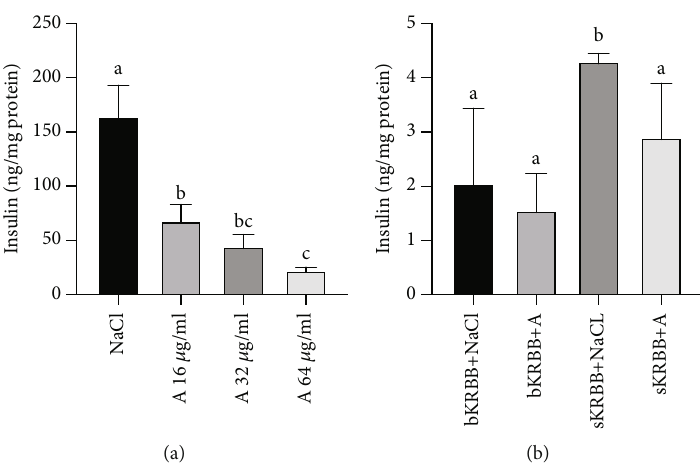
Figure 4: Insulin concentration in the media of BRIN-BD11 cells, after chronic (a) and acute (b) insulin secretion assay. (a) Chronic insulin secretion: 1 day after seeding of BRIN-BD11 cells in 96-well plates ( 5 × 10 3 cells/well), the cells were incubated for another 24h in their regular growth medium, in the absence or presence of porcine pancreatic amylase (a) ( fi nal concentrations of 16, 32, and 64 μ g/ml, resulting in a fi nal activity of 35.9, 69.2, and 114.5U/l, respectively). Sterile 0.9% NaCl was used as a vehicle. Data are the mean of 32 independent cell cultures (for each treatment) from two independent experiments. (b) Acute insulin secretion: BRIN-BD11 cells were seeded in 24-well plates ( 1 : 5 × 10 5 cells/well) in the routine medium. After 24 h of incubation, the cells were starved for 40 minutes in bKRBB. The cells were then challenged with sKRBB, in the presence or absence of 32 μ g/ml porcine pancreatic amylase (a) for 20 min. Sterile 0.9% NaCl was used as a vehicle. Data are the mean of 12 independent cell cultures (for each treatment) from two independent experiments. bKRBB: basal medium; sKRBB: stimulative